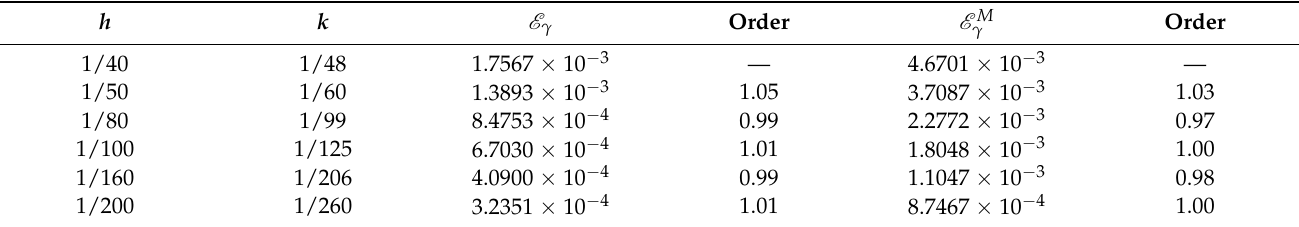
Table 9. E γ , E M γ and numerical convergence order in the temporal direction ( γ = 0.95, h ≈ k